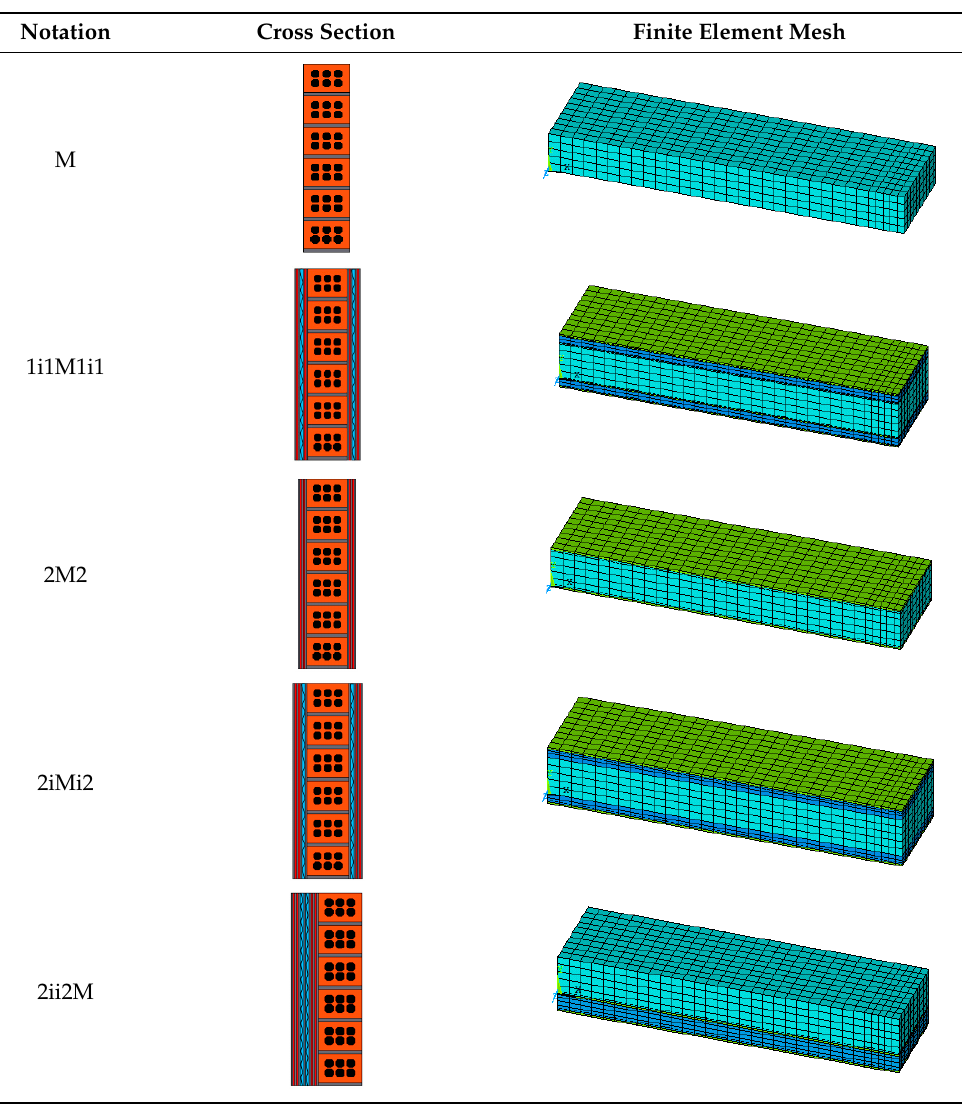
Table 4. Out-of-plane loaded specimens and finite element models.